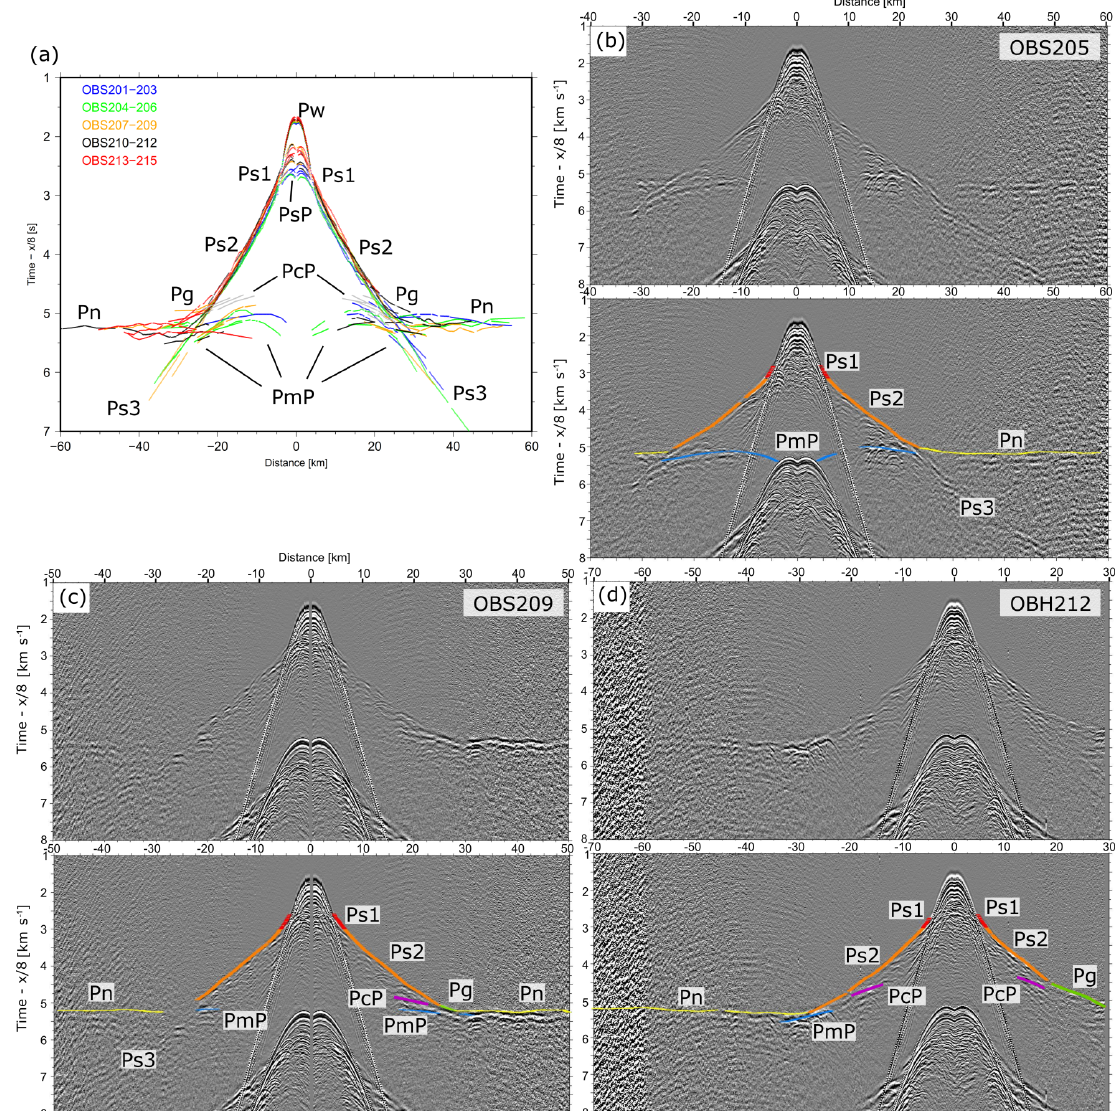
Figure 2. (a) Stacked travel time picks of all 15 stations showing very similar arrivals, suggesting an almost 1D structure along the profile. (b) Record section of station OBS205 (time reduced with a velocity of 8kms − 1 ). The lower panel shows the calculated travel time picks from the final velocity model superimposed on the seismic data. (c) Record section and calculated travel times of station OBS209. (d) Record section and calculated travel times of station